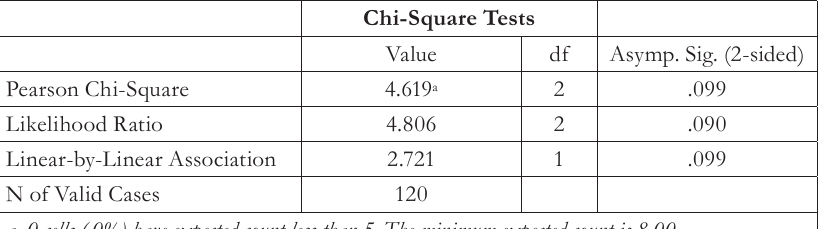
Tab. 1 - Satisfaction with banking products and services versus Nationality. Source: Author´s own,